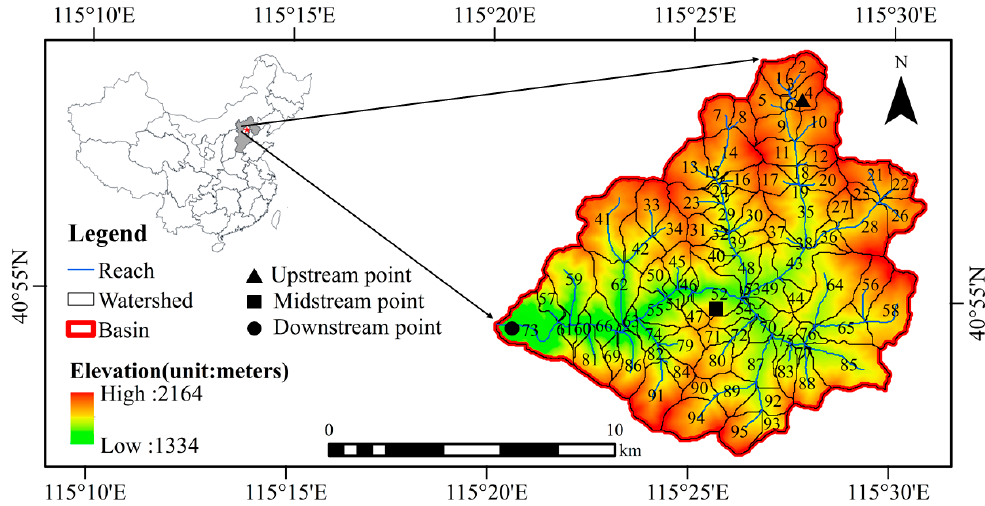
Figure 1. The study area and relevant DEM, sub-basins, and monitoring points.